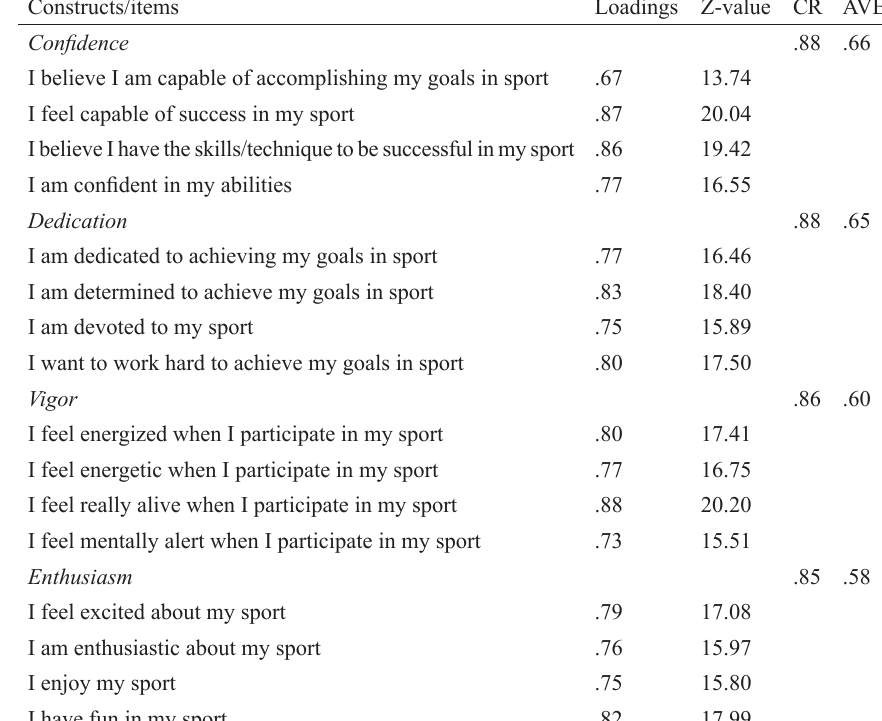
Table 2. Factor loadings, Z-values, composite reliability (CR), and average variance extracted